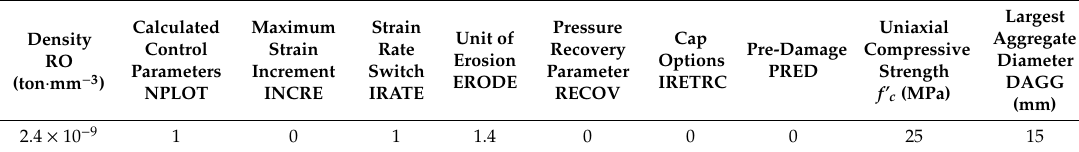
Table 1. The material parameters of concrete.